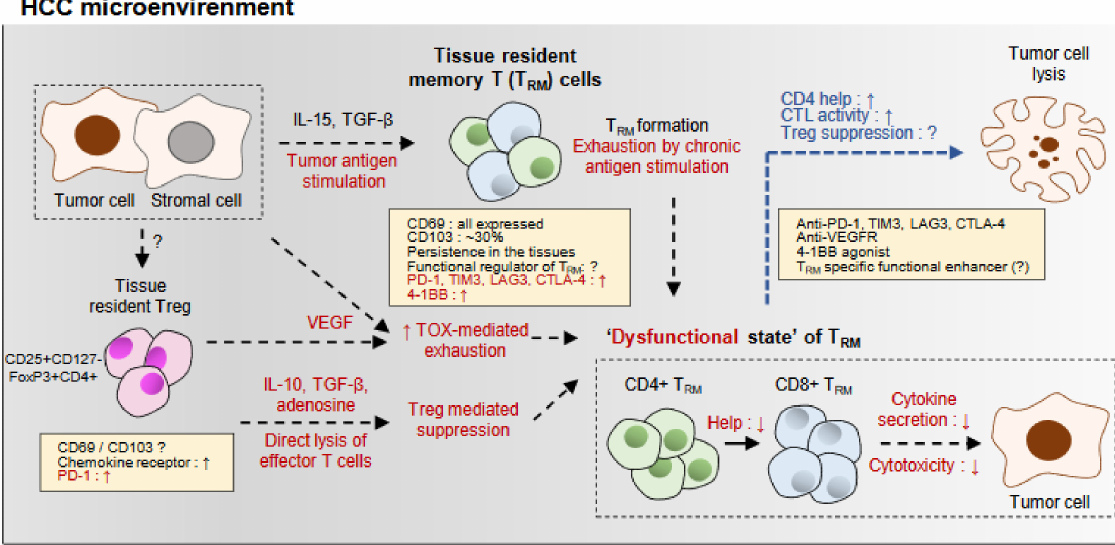
Figure 1. Tissue-resident memory T (T RM ) cells in hepatocellular carcinoma (HCC). The summary of the generation, characteristics, and functional restoration of T RM cells within HCC is presented. T RM cells are generated by tumor antigen recognition in the presence of interluekin (IL)-15 and transforming growth factor- β (TGF- β ) secreted by tumor cells and stromal cells such as fibroblasts. The mechanism of the generation of tissue-resident regulatory T (Treg) cells and their phenotypic characteristics are still not known. T RM cells can persist within tumor tissues and perform tumor killing via cytokine secretion and cytotoxicity. However, due to the chronic antigen stimulation, vascular endothelial growth factor (VEGF, secreted by tumor cells, stromal cells, and Treg cells)-mediated enhancement of HMG-box transcription factor TOX - mediated T cell exhaustion and Treg-mediated suppression, T RM cells enter a “dysfunctional state”, which is characterized by low CD4+ help, low cytokine secretion, and cytotoxicity against tumor cells. Therefore, targeting immune checkpoint molecules such as programmed cell death protein-1 (PD-1), T cell immunoglobulin and mucin-domain-containing-3 (TIM-3), lymphocyte-activation gene-3 (LAG-3), and cytotoxic T-lymphocyte-associated antigen-4 (CTLA-4) restores the dysfunction of the T RM cells. In addition, because T RM cells have unique phenotypic and transcriptional characteristics compared with other subset of T cells, whether targeting their own molecules might result in the enhancement of their anti-tumor function needs to be investigated. Each arrow indicate that the one before the arrow affects the one after it. Question mark represents the hypothesis which is